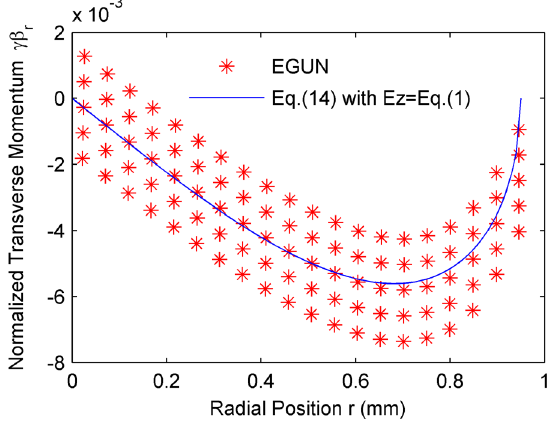
FIG. 19. Transverse phase-space of a beam next to the concave cathode. The curve and dots stand for the analytical and numerical results,